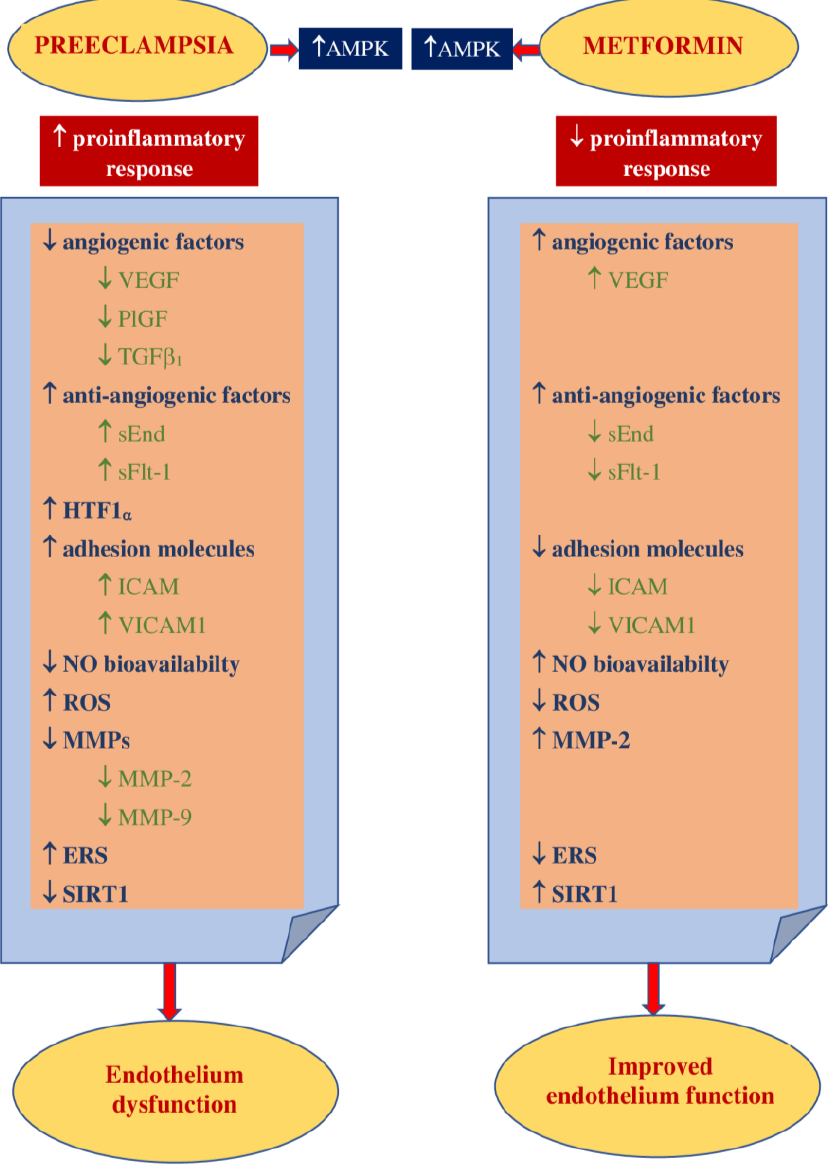
Figure 2. Theoretical basis for the use of metformin in PE prevention. AMPK — 5’ adenosine monophosphate-activated protein kinase, VEGF—vascular endothelial growth factor, PlGF—placental growth factor, TGF β 1 —transforming growth factor-β 1 , sEnd—soluble endoglin, sFlt-1—fms-like tyrosine kinase-1, HTF1 α — hypoxia-inducible factor 1α, ICAM1—in- tracellular cell adhesion molecule 1, VICAM1—vascular cell adhesion molecule 1, NO—nitric oxide, ROS—reactive oxy- gen species, MMPs—matrix metalloproteinases, MMP-2—matrix metalloproteinase-2, MMP-9—matrix metalloprotein- ase-9, ERS—endoplasmic reticulum stress, EPCs—endothelial progenitor cells,